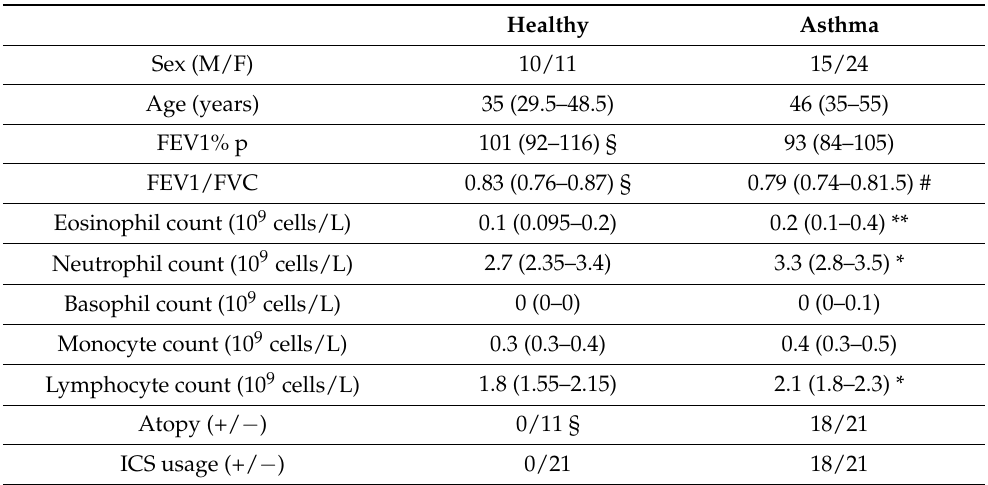
Table 1. Demographic and clinical characteristics of study